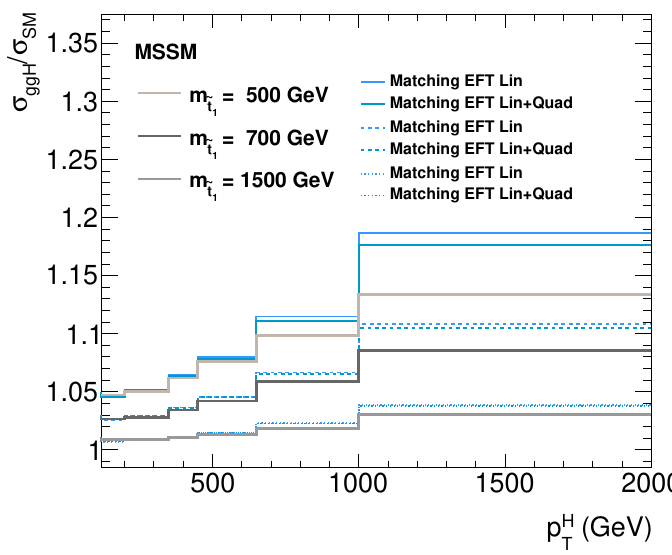
Figure 5. p H spectra normalised to the SM prediction for the three MSSM-like benchmark points T with varying ˜ t 1 masses. The SMEFT spectra for the matched Wilson coefficients and only linear and linear plus quadratic terms for the m ˜ =500 GeV and 1500 GeV benchmarks are also shown. t